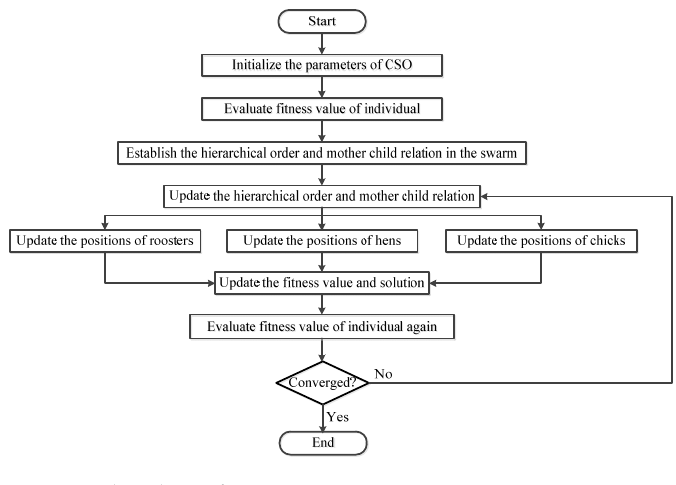
Figure 7. Flowchart of CSO.